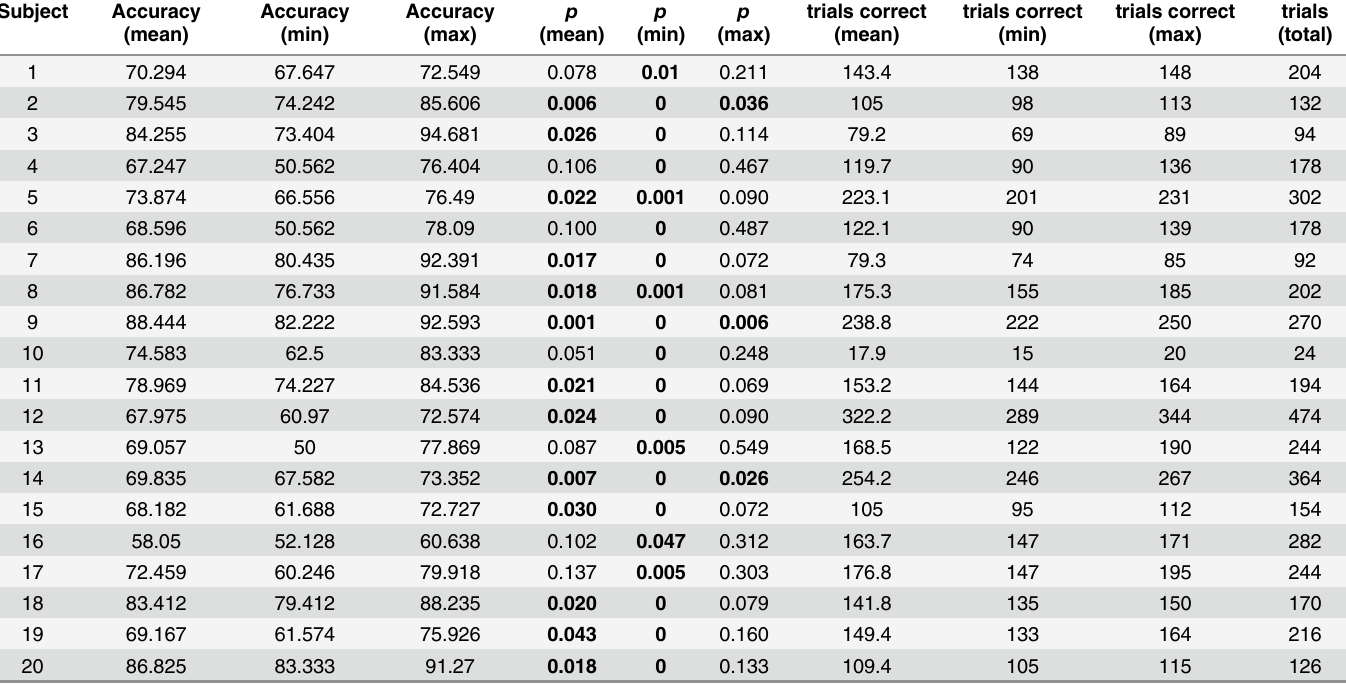
Table 10. Results Across Task: Train Rotation, Classify